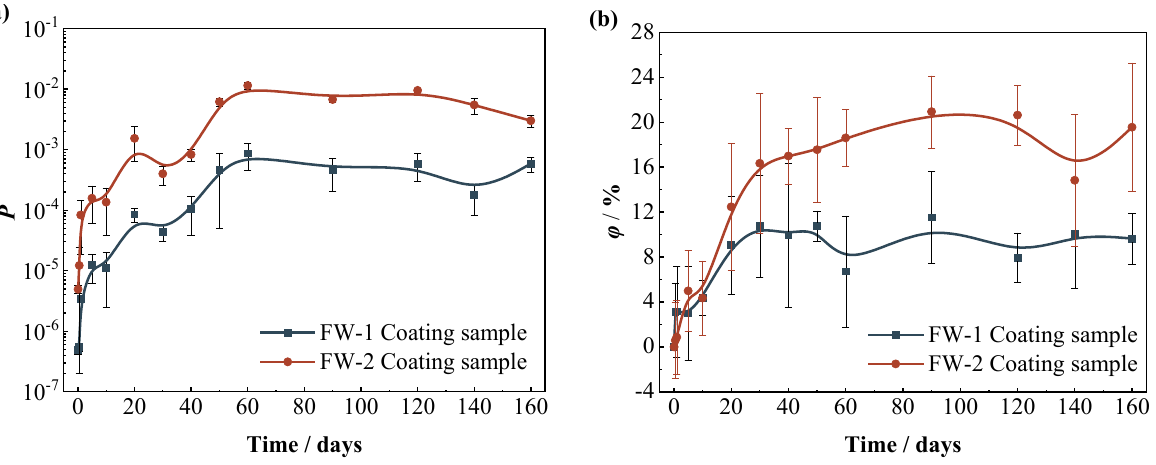
Figure 8. Variations of ( a ) porosity and ( b ) water absorption of two coating systems with time.